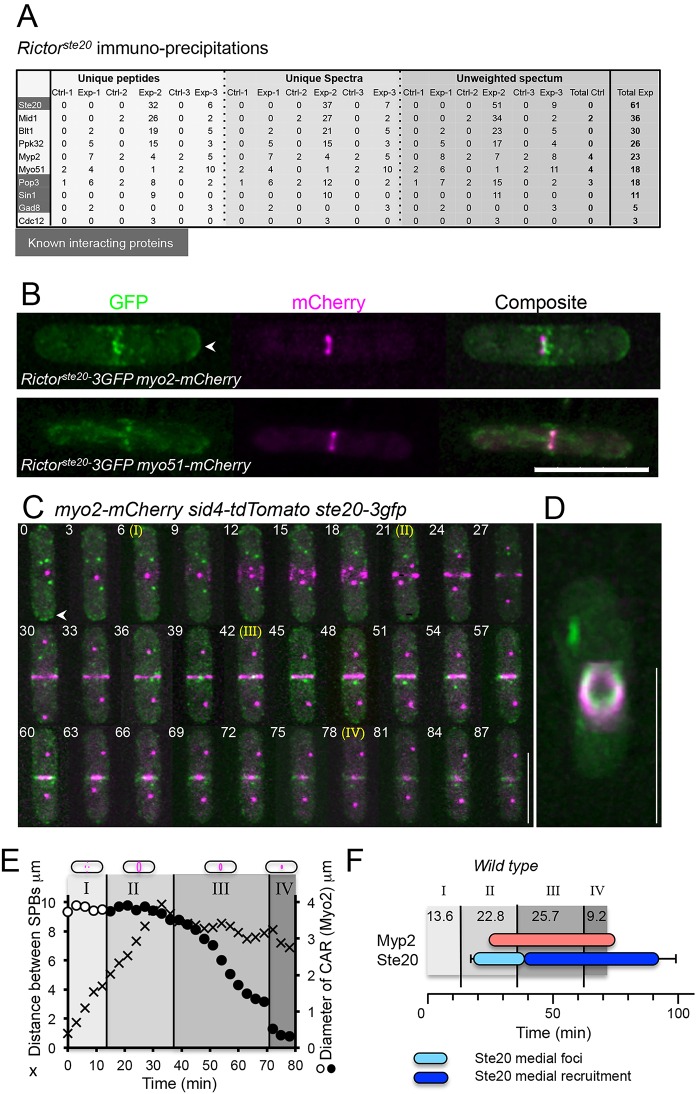
TORC2 interacts with and localises to the CAR during ring constriction. (A) Summary of mass spectrometry analysis of three independent experiments of control (Ctrl, no anti-Tor1 antibodies added) and Tor1 immunoprecipitations (Exp), each purified from 20-l cell cultures. (B) Micrographs of RICTORSte20 (green) and Myo2 or Myo51 (magenta) signal from mitotic RICTORSte20–3GFP
myo2–mCherry cells or RICTORSte20–3GFP
myo51–mCherry cells. (C,D) Maximum projections of 21-slice z-stacks from a timecourse of mitotic myo2–mCherry sid4–tdTomato
RICTORSte20–3GFP cells reveals that RICTORSte20 foci (green) are recruited to the cell equator after SPB (magenta) separation and Myo2 ring (magenta) formation has occurred (frame 1–4 with non-separated SPBs represent interphase cells) (C) and coalesce to form a ring during CAR constriction. (D) Micrograph of mCherry and GFP signal from a RICTORSte20–3GFP
myo2–mCherry cell illustrating TORC2 association with the CAR. In B and C, arrowheads highlight RICTORSte20 localisation at cell tips. (E) The timing of key events during CAR formation and constriction [(I) Myo2 foci (empty circles) recruit to the cell equator; (II) Myo2 foci coalesce to form a CAR (filled circles); (III) the CAR constricts until, (IV) it reaches a diameter of 0.5 µm or less] were determined in relation to nuclear division (crosses, distance between SPBs) in wild-type. (F) The timing of the appearance of Myp2 ring (red bar) and RICTORSte20 medial foci (light blue bar) or RICTORSte20 ring recruitment (dark blue) were determined in wild-type strains in relation to the events determined in E. Scale bars: 10 µm.